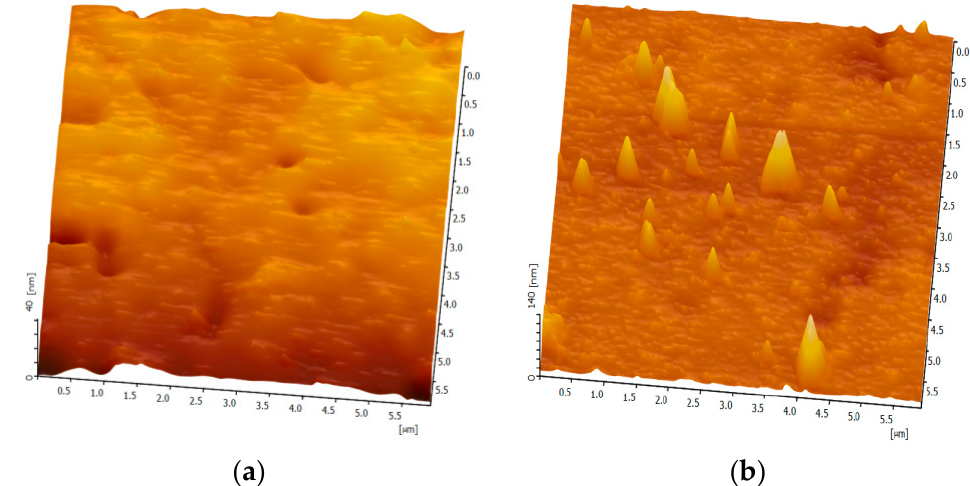
Figure 4. Atomic force microscopy (AFM) morphologies of flat silicon surfaces grafted with PSVBA brushes: ( a ) 20-h grafted surface; ( b ) 48-h grafted surface.